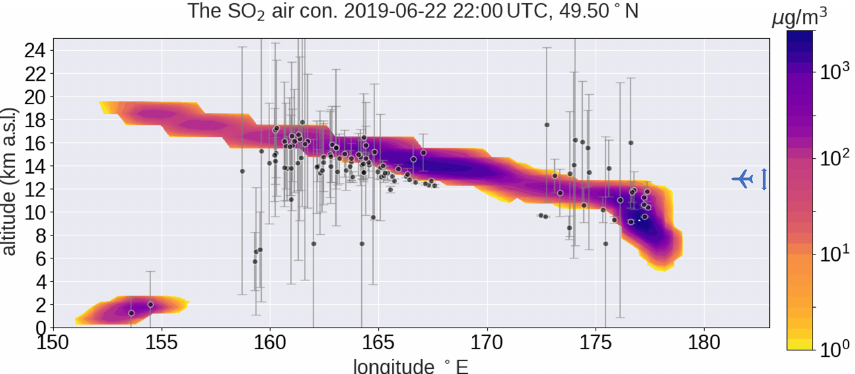
Figure 4. Vertical cross section of SO 2 mass concentrations (µgm − 3 ) in the VolRes1.5 simulation and the IASI height estimate along the line I–II in Fig. 3a on 22 June 2019 at 22:00UTC. This time corresponds with the IASI overpass over the volcanic cloud, thereby minimising displacement errors due to timing. The black dots represent the available height estimates including error bars from the IASI retrieval of the SO 2 cloud for all pixels between 49–50 ◦ N, and it is estimated following the method described in Carboni et al. (2016). The blue arrow on the right of the figure indicates the range of cruise altitudes for long-haul aircraft